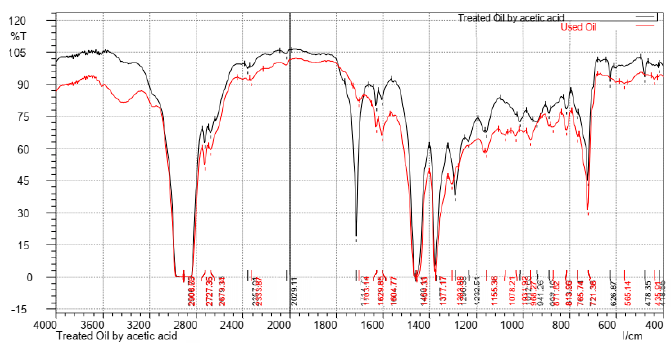
Figure 9. Superposition of IR spectra: used oil and oil treated with acetic acid.